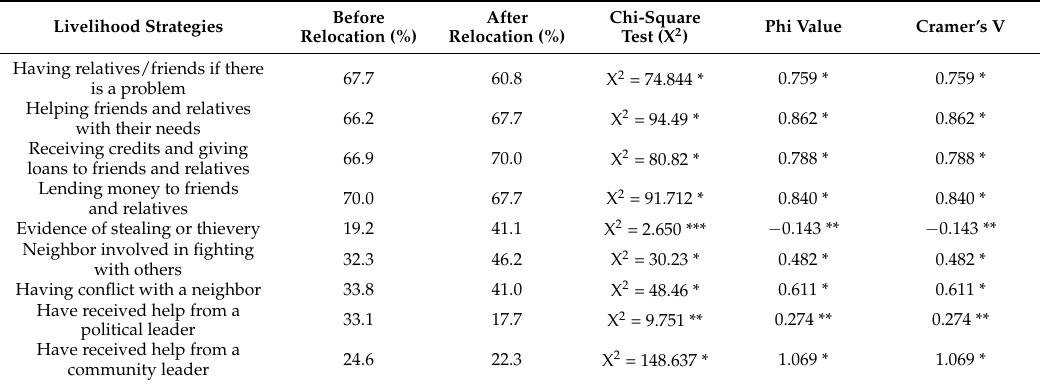
Table 7. Strategies related to social life and security before and after